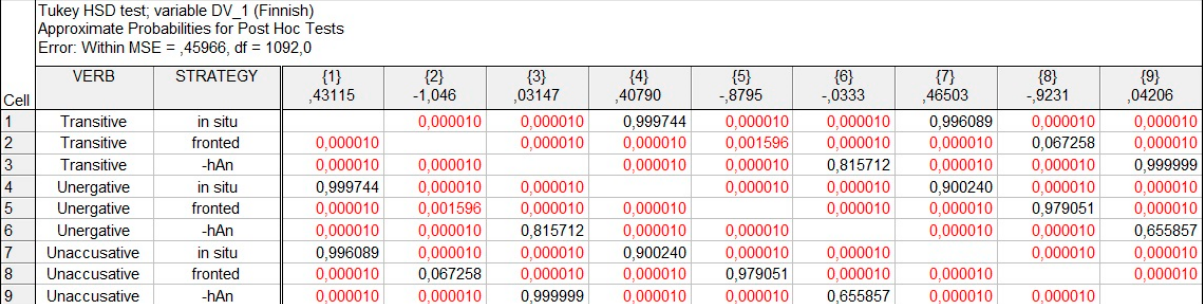
Figure 5. Verb*Strategy interaction (Finnish) .